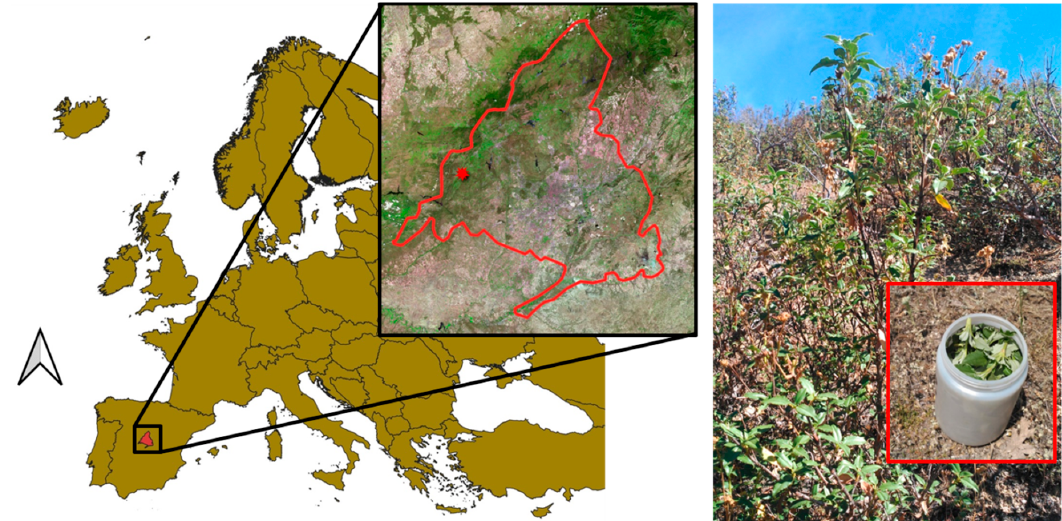
Figure 1. Location of the study area and example of a field sample collected in the C. ladanifer shrubland.